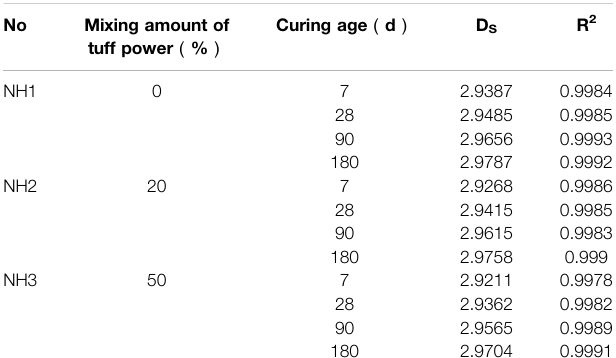
TABLE 6 | The Ds and R 2 of tuff powder-cement